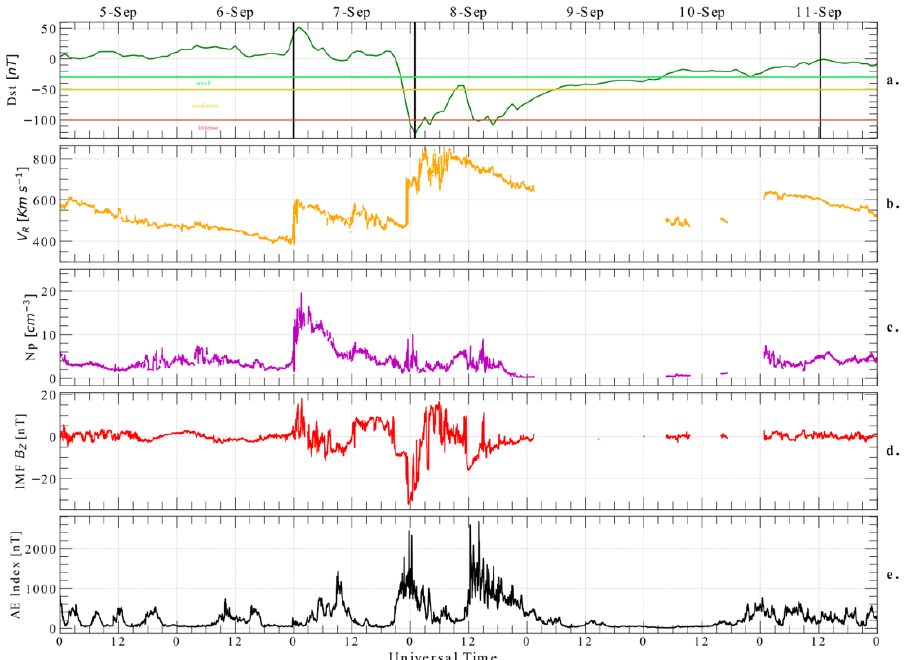
Figure 2. ( a ) The Dst index; ( b ) the solar wind velocity V R ; ( c ) the number density of protons N P ; ( d ) the interplanetary magnetic field component Bz; and ( e ) the AE index from 5–11 September 2017.